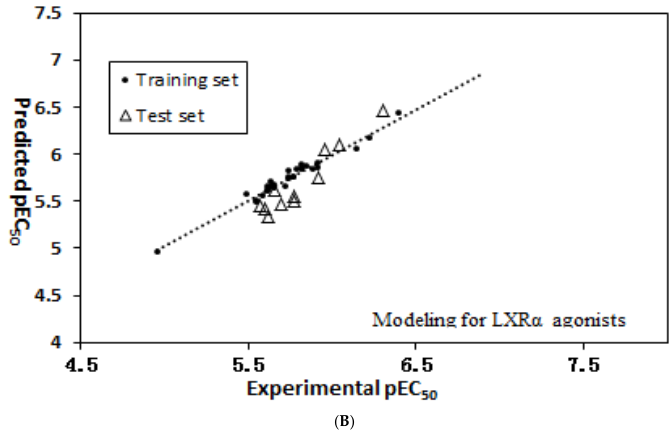
Figure 2. Plots of experimental pEC 50 values against predicted pEC 50 values by QSAR models for LXRβ agonists ( A ) and LXRα agonists ( B ). Table 1. Selected descriptors of MLR model for LXR β agonists.